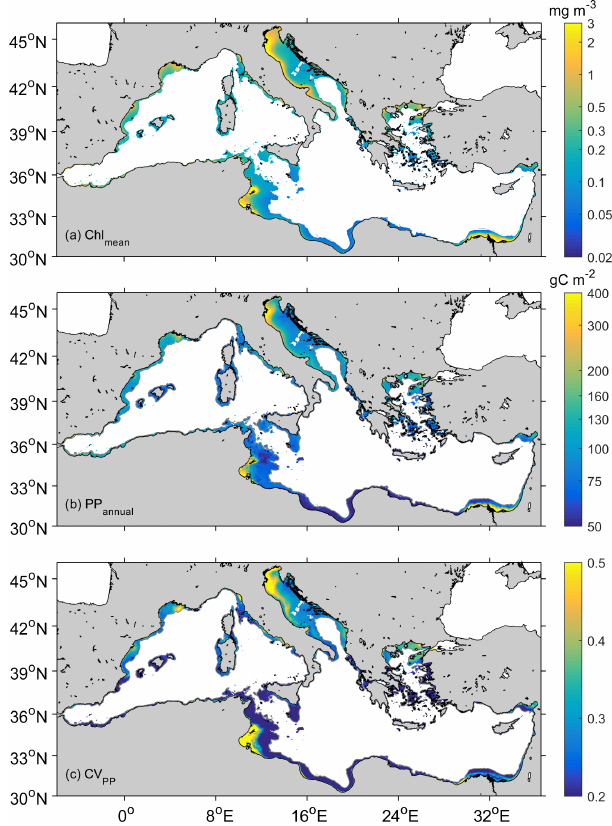
Figure 2. Mean distribution of (a) chlorophyll (chl mean , in mgm − 3 ), (b) annual PP (PP annual , in gCm − 2 ), and (c) coefficient of variation in PP values (CV PP